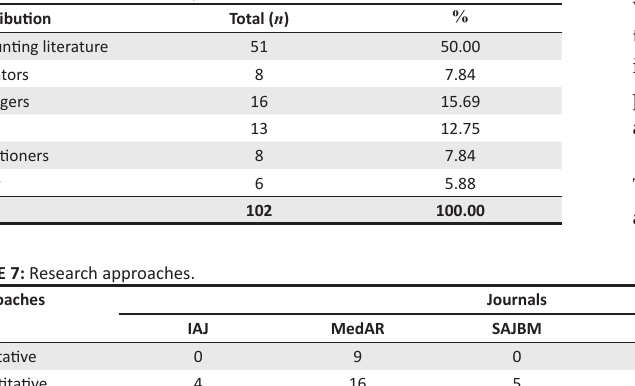
TABLE 6: Stated contribution by articles – 2015–2016.